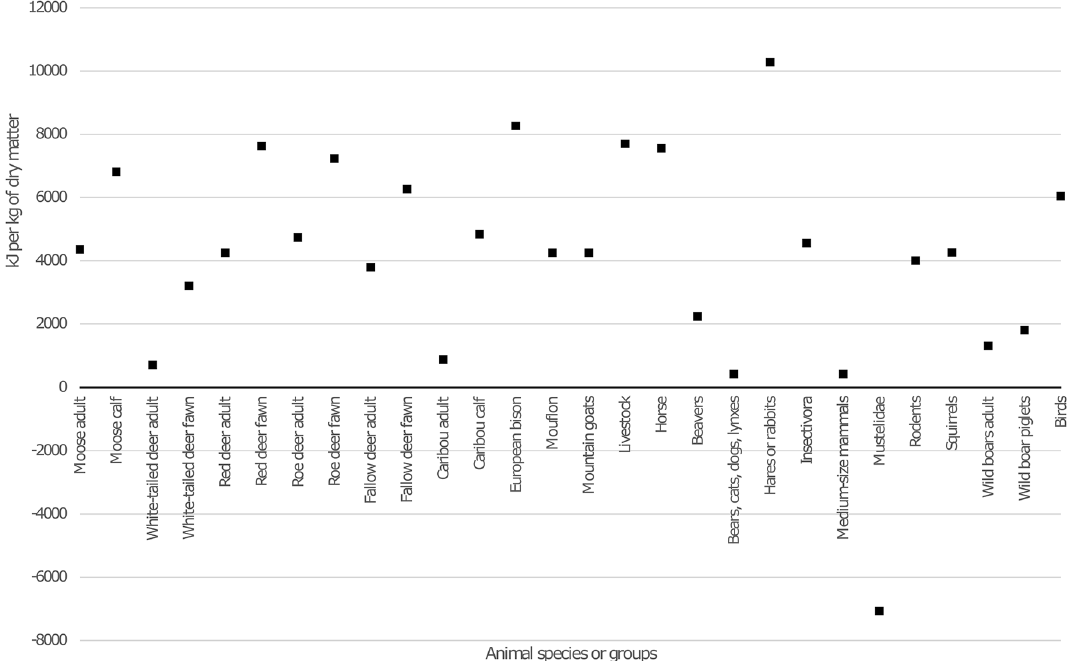
Figure 2. Humans have a limited capacity to digest protein. Calculation based on 45% of energy demands from animal protein leads to “left over” energy of hundreds or thousands kJ per kg of dry animal (see supplementary). This excess protein can be fed to